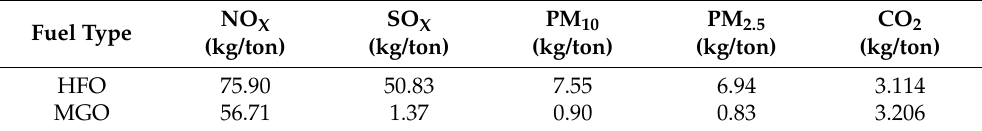
Table 4. The used emission factors